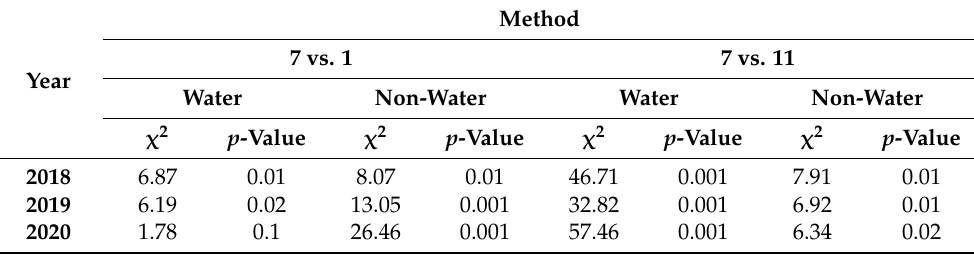
Table 3. McNemar’s test for method 7 against methods 1 and 11 (Table 2). Method 7 vs. 1 7 vs. 11 Year Water Non-Water Water